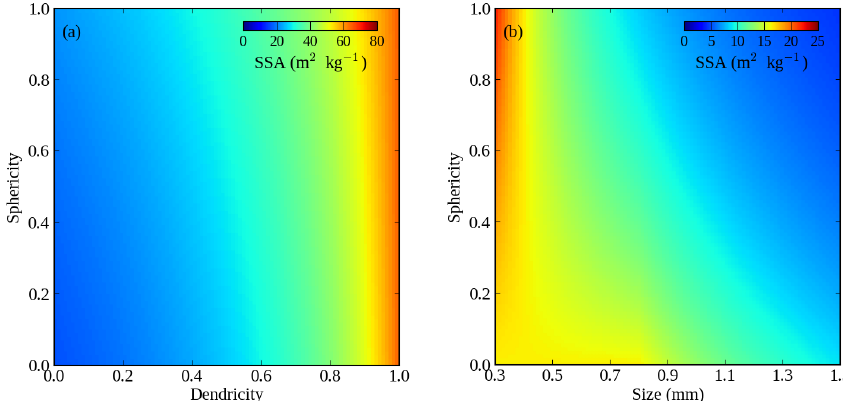
Fig. 1. Relationship between SSA and grain variables in the original Crocus version. Empirical equations (Vionnet et al., 2012) were used to estimate the optical diameter (a) from dendricity and sphericity in the dendritic case and (b) from sphericity and size in the non-dendritic case. Then, the optical diameter was converted into SSA using Eq. 1.